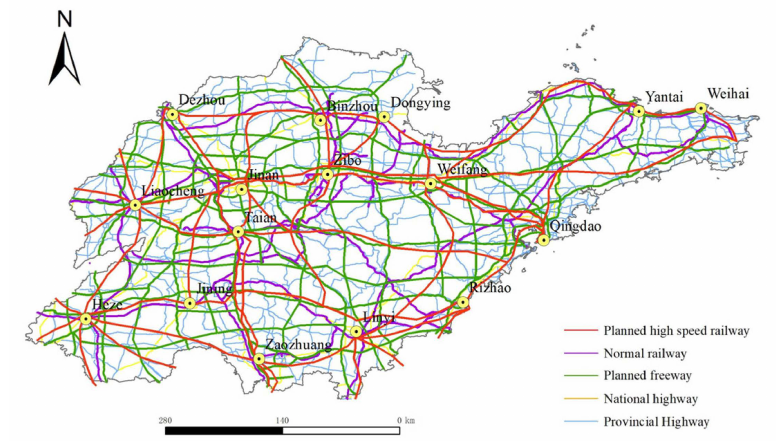
Figure 2. Planned road network of Shandong Province, China, in